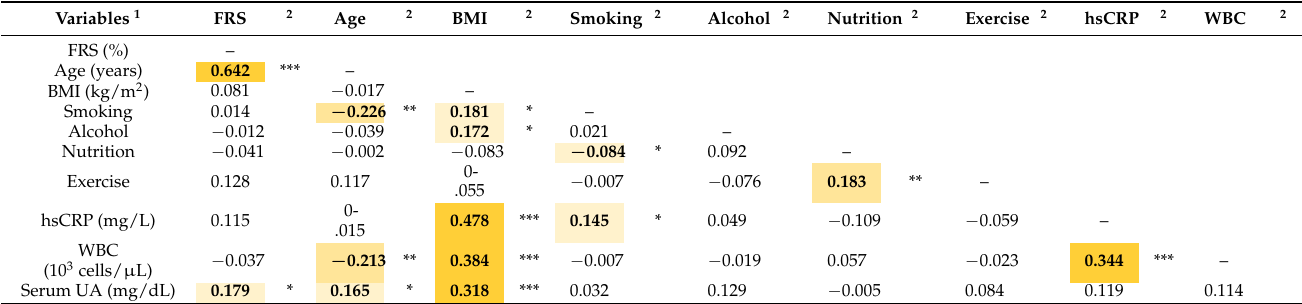
Table 3. Crude correlations between FRS, age, BMI, health-related lifestyle, and CVD risk markers in female workers. Variables